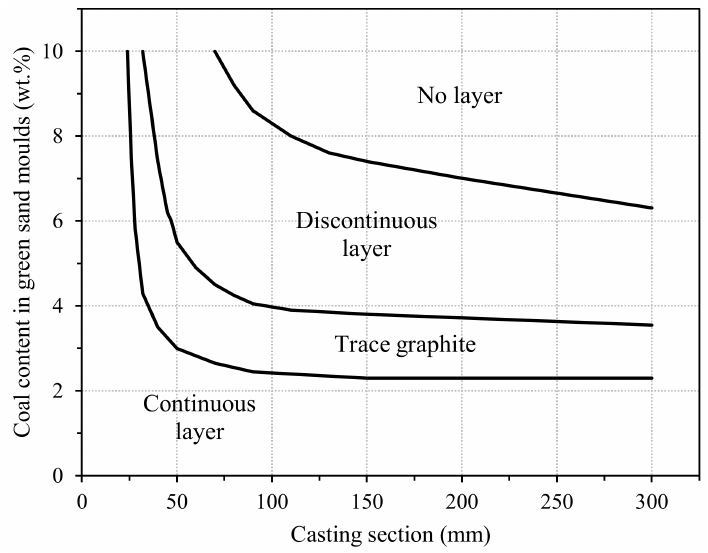
Figure 58. Effect of casting section and of coal content present in green sand molds on the characteris- tics of the decarburized layer [42].